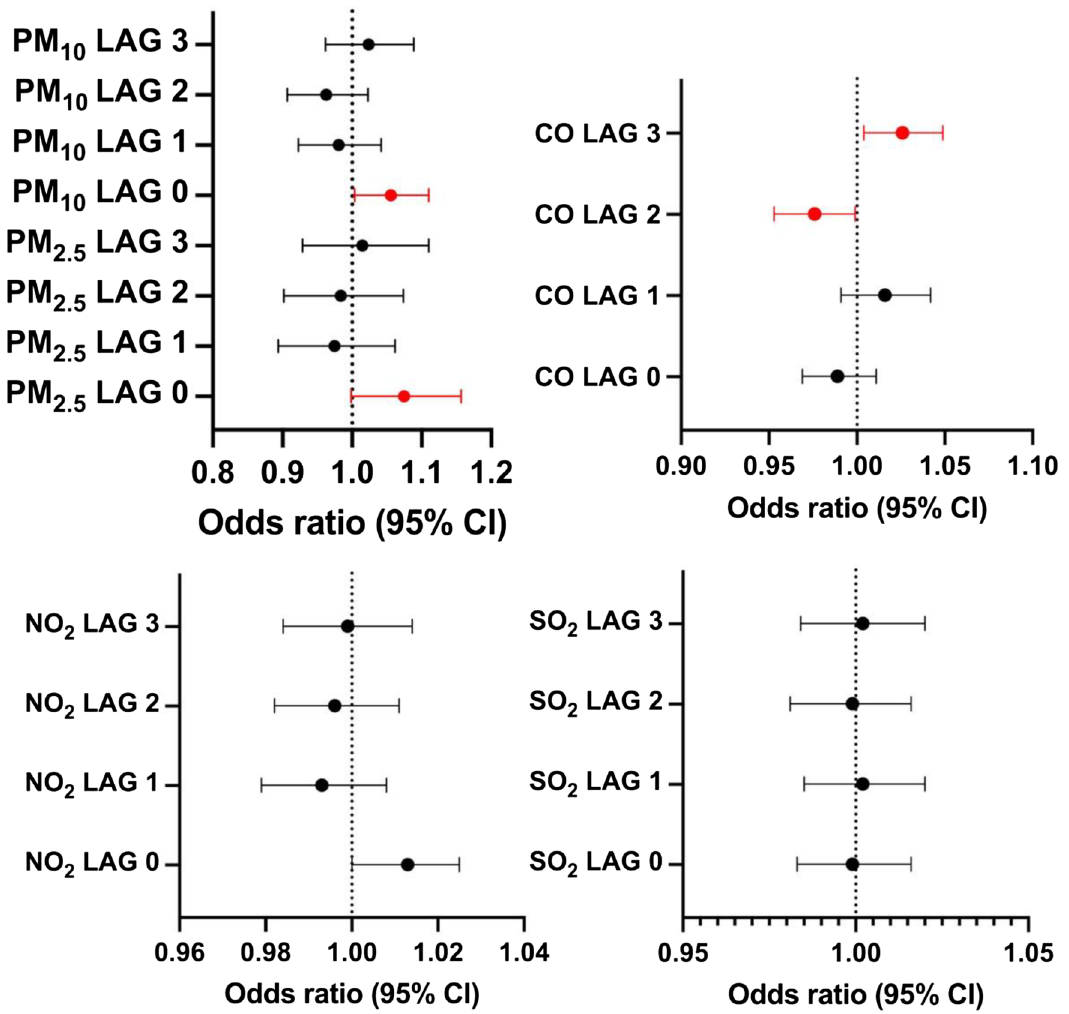
Figure 1. Overall associations between the exposure to short-term pollutants and ischemic stroke